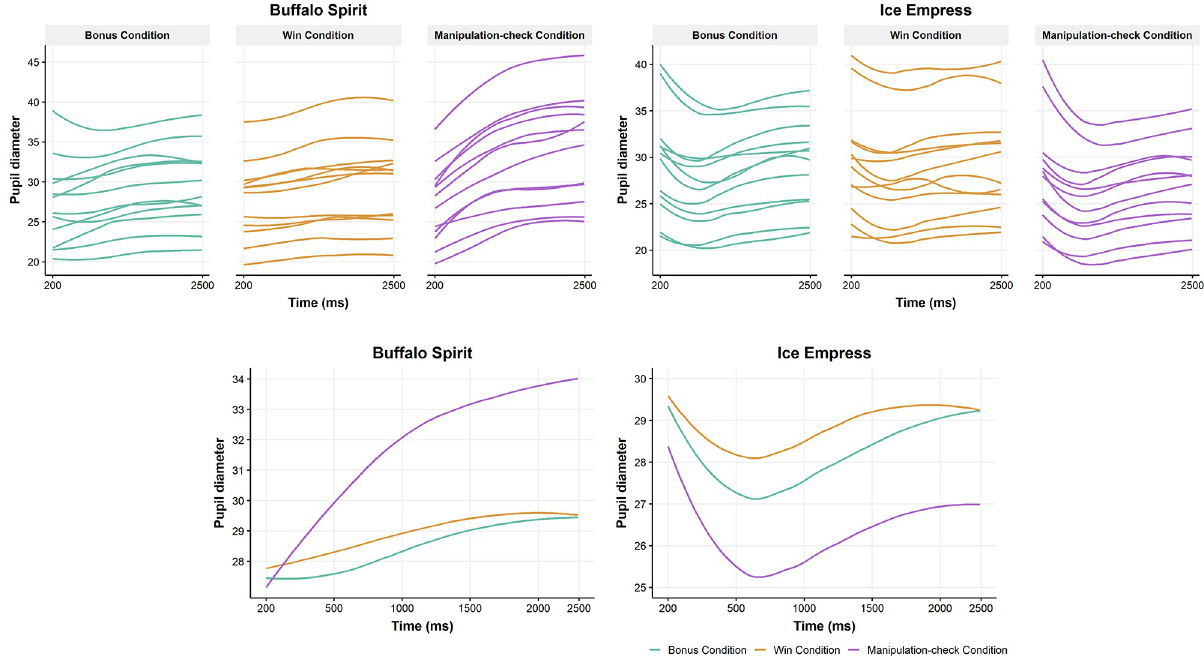
Fig 7. Pupil time-course. In the top row, lines indicate the mean pupil diameter from 200 to 2500 ms on Trial B for each participant (n = 12). In the bottom row, lines indicate the mean pupil diameter from 200 to 2500 ms on Trial B aggregated across participants. Pupil diameter is estimated as pixels as observed in the eye on the camera image, and is therefore not corrected for